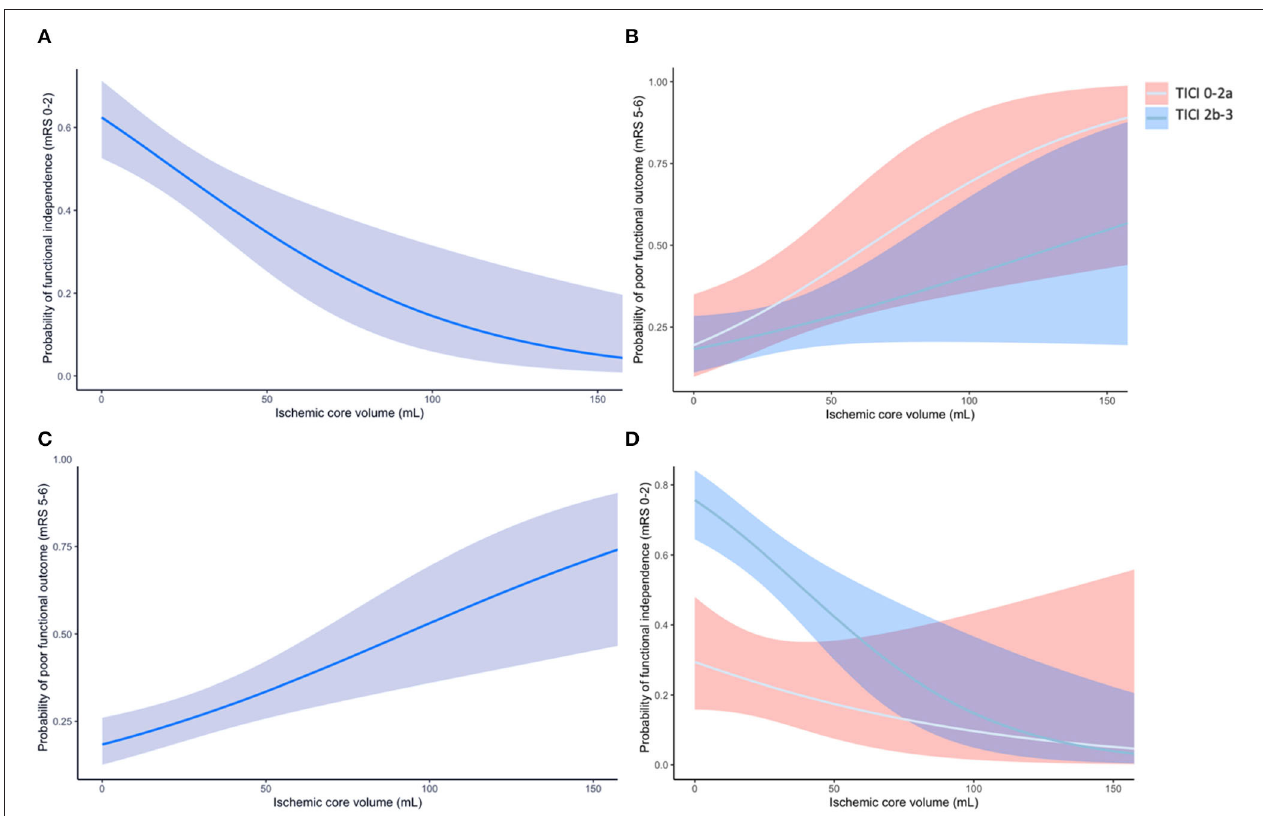
FIGURE 2 | (A) The association of CTP ischemic core volume with the probability of poor outcome (mRS 5-6) at 90 days. (B) The association of CTP ischemic core volume with the probability of poor outcome for patients with successful reperfusion (eTICI 2b-3; blue line with blue area representing the 95%CI) and unsuccessful reperfusion (eTICI 0-2a; gray line with red area representing the 95%CI). (C) The association of CTP ischemic core volume with functional independence (mRS 0-2) at 90 days. (D) The association of CTP ischemic core volume with the probability of functional independence for patients with successful and unsuccessful reperfusion. The effect of successful reperfusion (eTICI 2b-3) on achieving functional independence was modified by CTP ischemic core ( p for interaction <